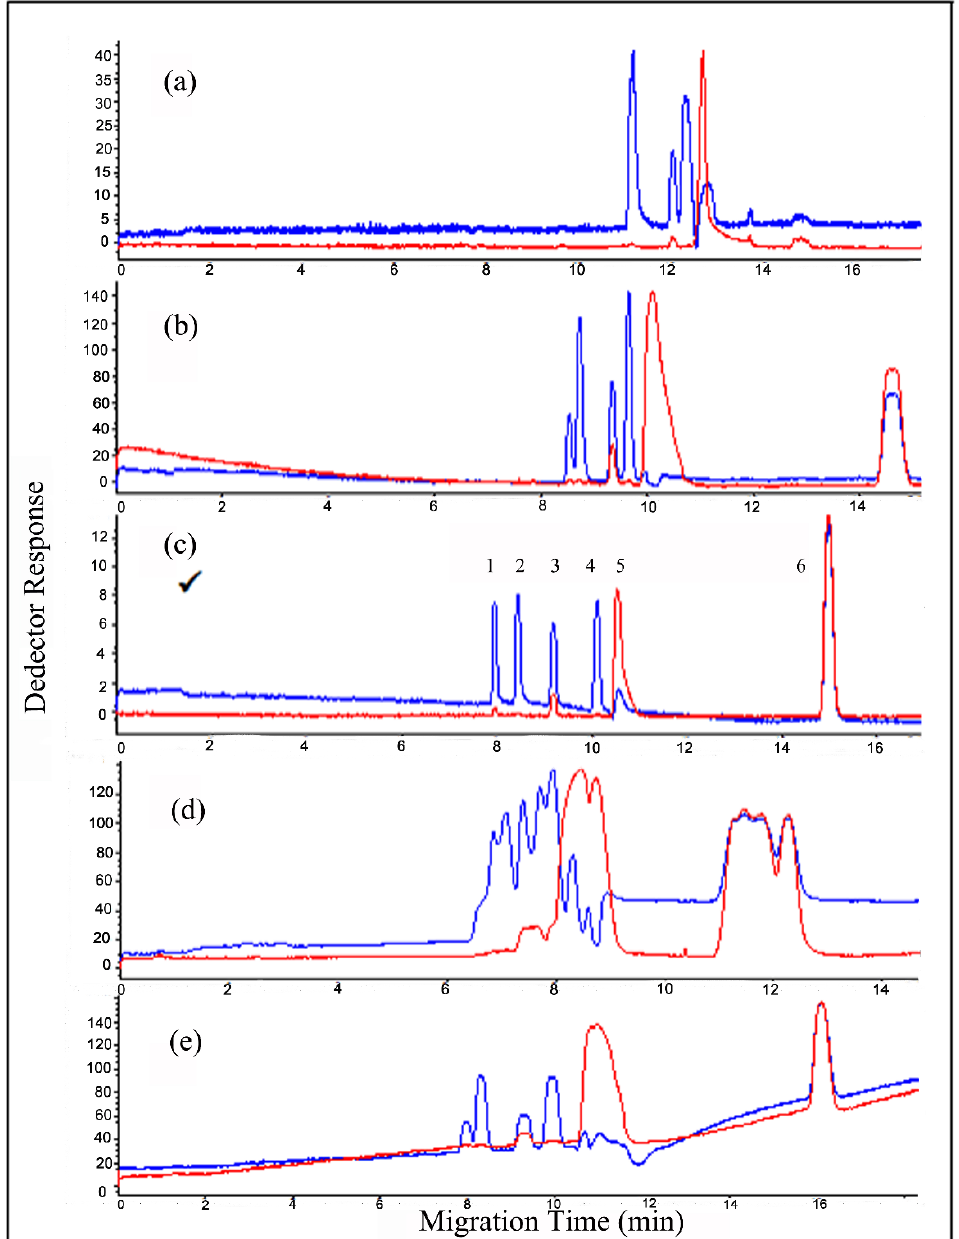
Figure S1- Effect of percentage of organic solvent on analysis λ=214 nm (blue line), λ=257 nm (red line), Percentages